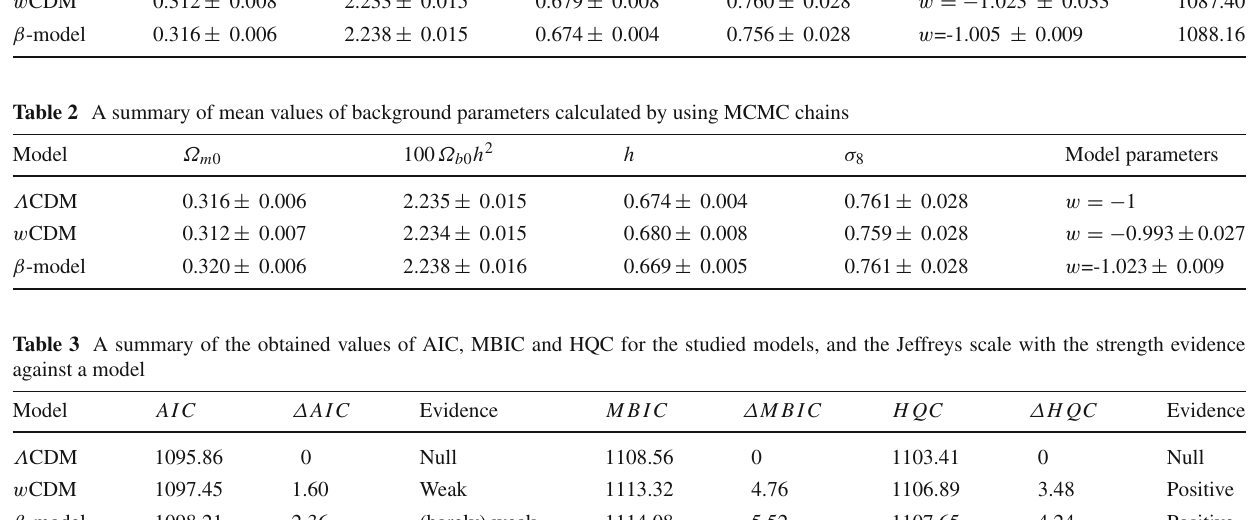
denotes the χ 2 best-fit values from bf